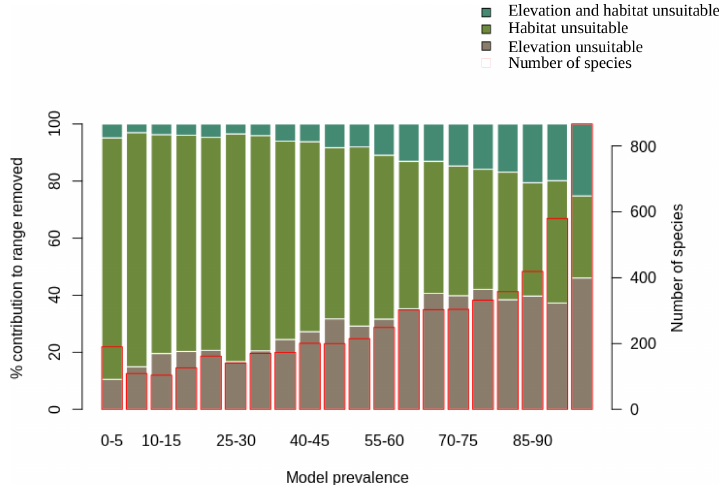
Figure 2. Percentage contribution of elevation range, habitat and both in clipping the IUCN range to AOH for mammals. See caption to Fig. 1 for